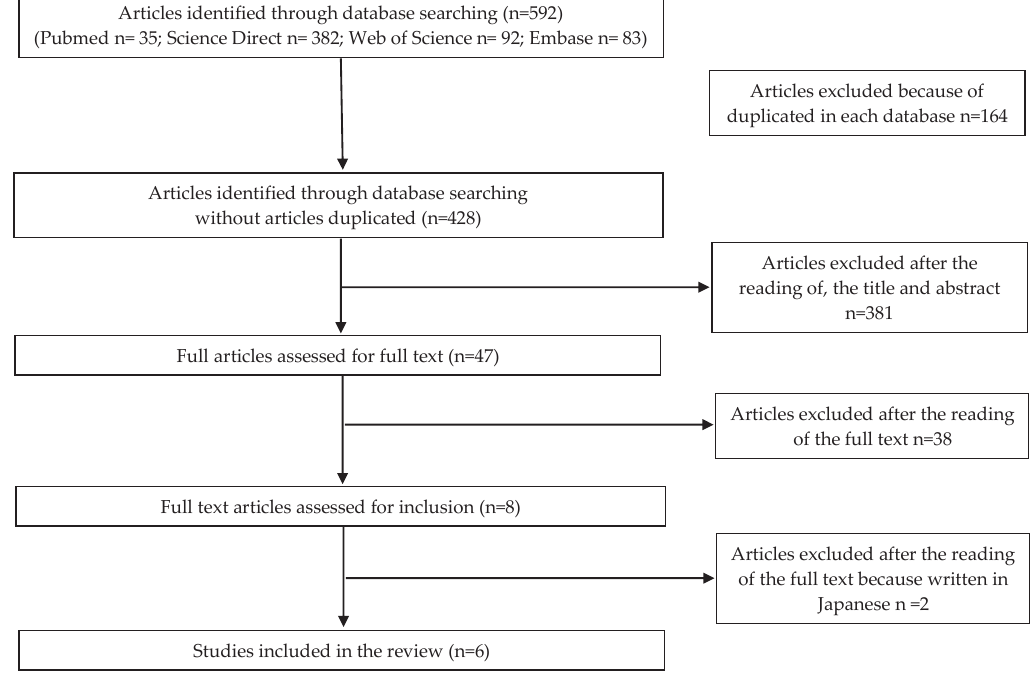
Figure 2. PRISMA (Preferred Reporting Items for Systematic reviews and Meta-Analyses) selection for allergenic risk.